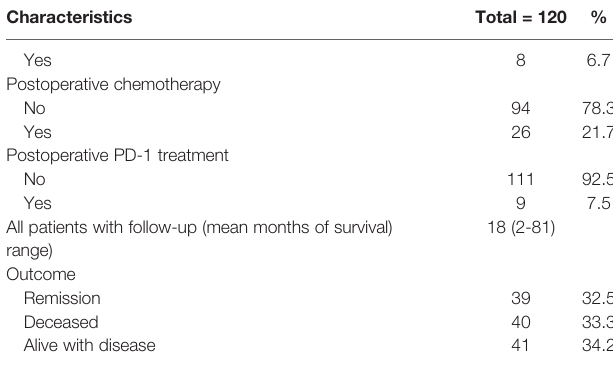
TABLE 1 | Characteristics of patients with advanced rNPC.